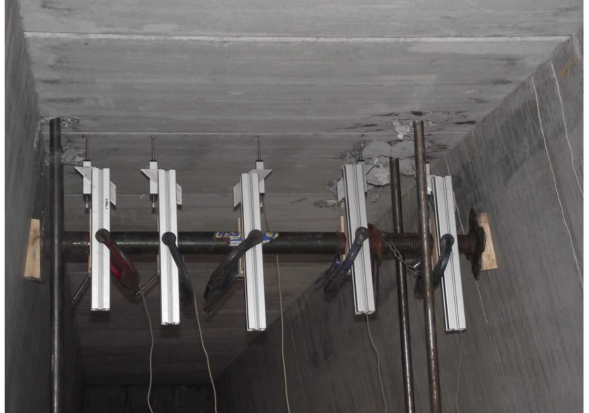
Figure 4. Position of the electronic displacement